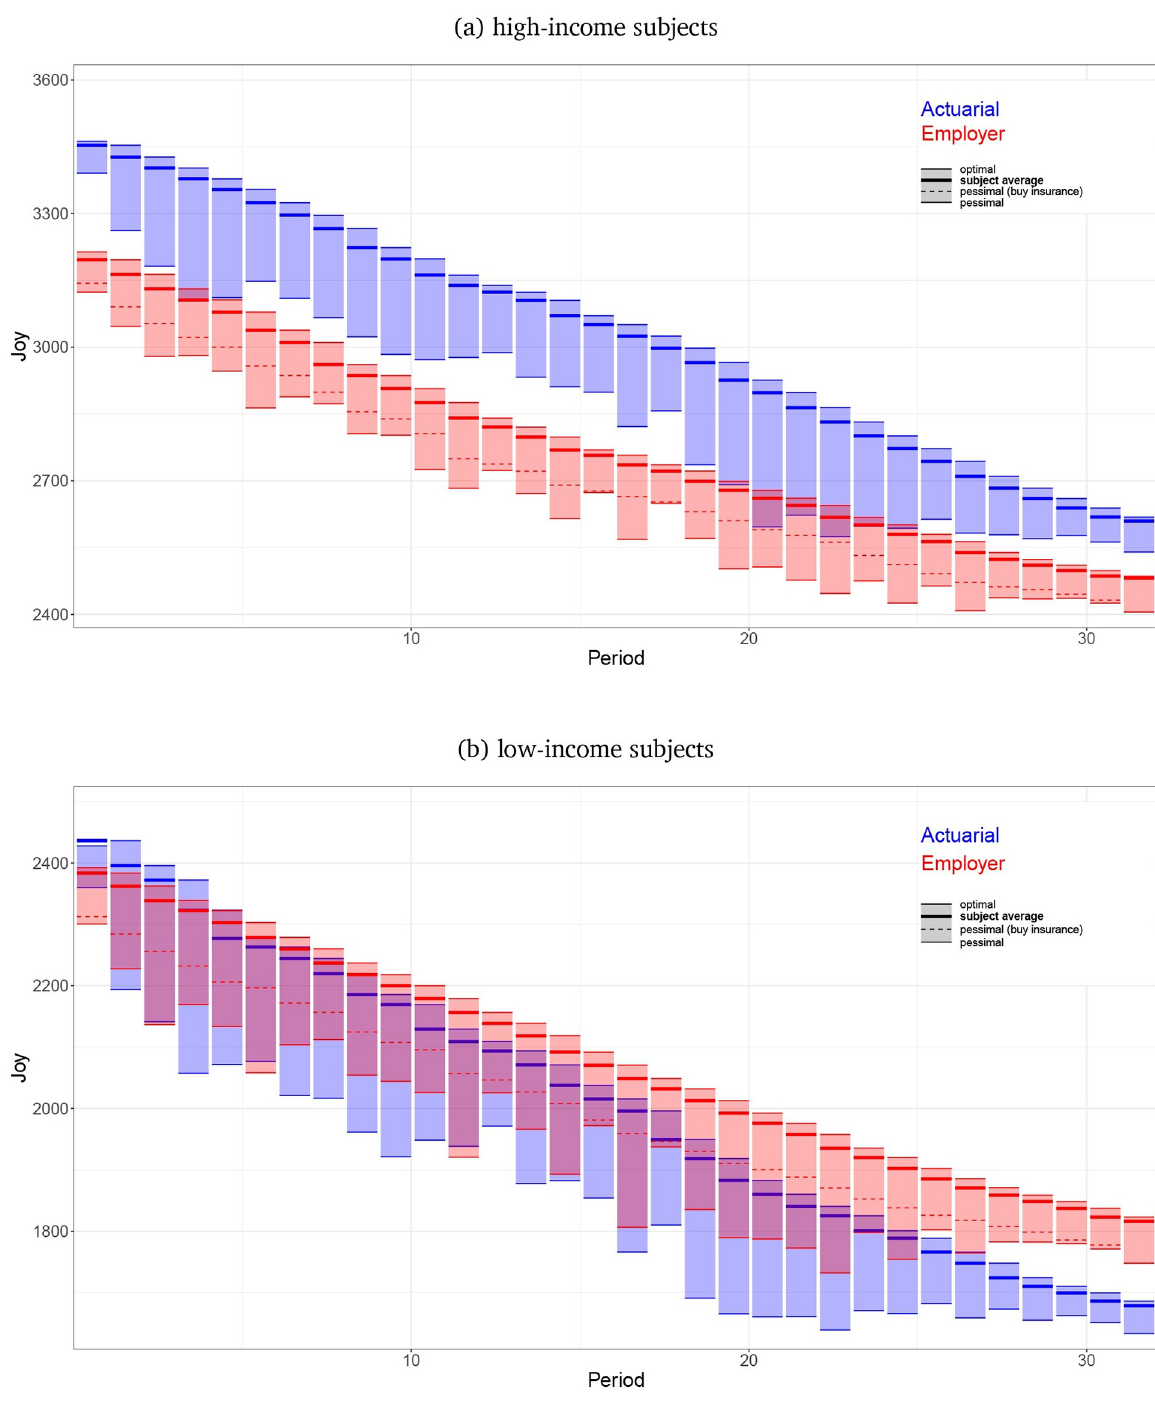
Fig 5. Joy earned by subjects compared to optimal. Includes panels: (a) High-income subjects, (b) Low-income subjects. employer treatment. This impact is much larger for low-income subjects for whom the actuar- ial bars start above the employer bars but quickly fall and stay below, revealing the greater cost of non-optimal decisions. The height of the vertical period-bars is greater for the actuarial